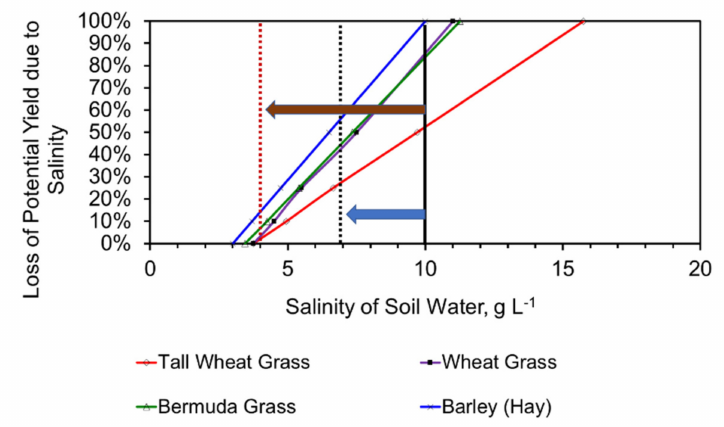
Figure 22. Salinity tolerance of four livestock grass crops. Solid black line = Expected soil salinity if it is irrigated with saline irrigation; Dotted black line = Expected soil salinity if it is irrigated with partially desalinated water; Blue arrow indicates the change associated with 30% desalination; Dotted brown line = Expected soil salinity if it is irrigated with partially desalinated water, Brown arrow indicates the change associated with 60%